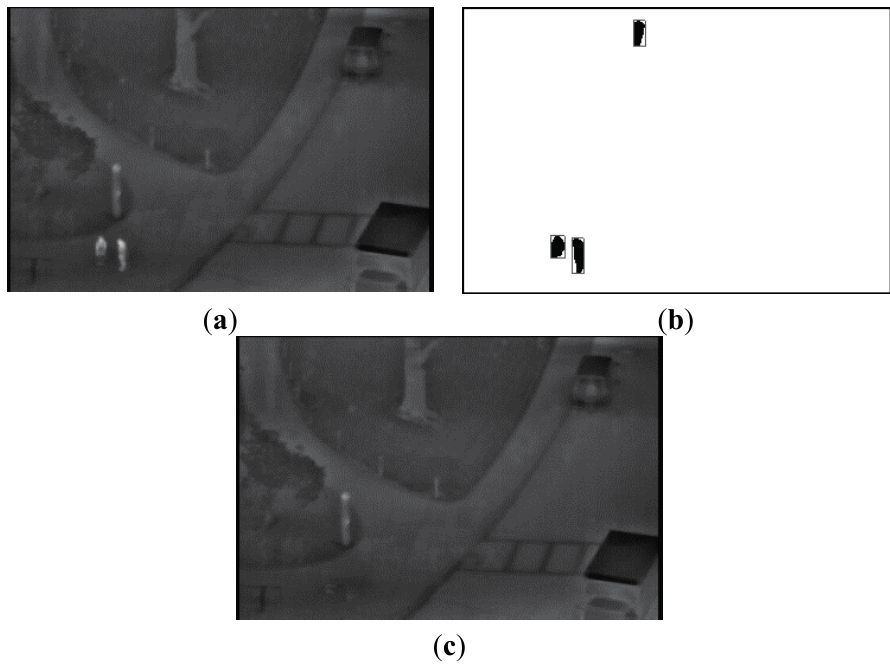
Figure 3. Examples of obtaining the background image from an open database: ( a ) preliminary background image obtained by temporal averaging; ( b ) extracted human areas by the binarization, labeling, size filtering and a morphological operation of Figure 2; and ( c ) the generated final background